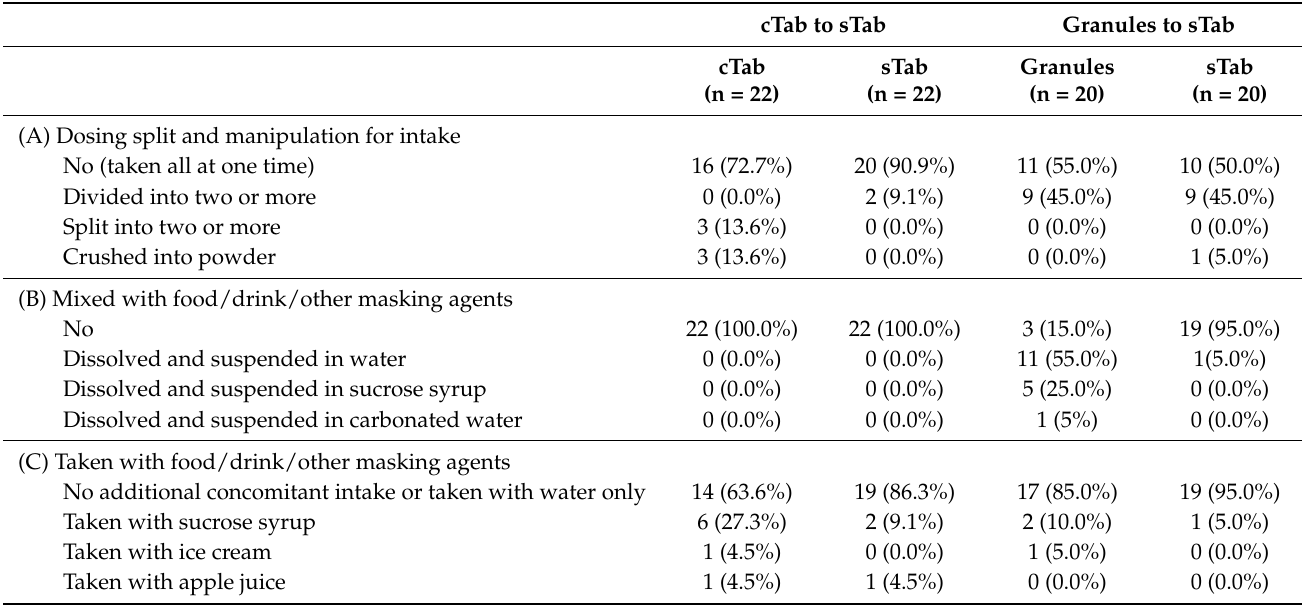
Table 4. Dosing methods and devices.